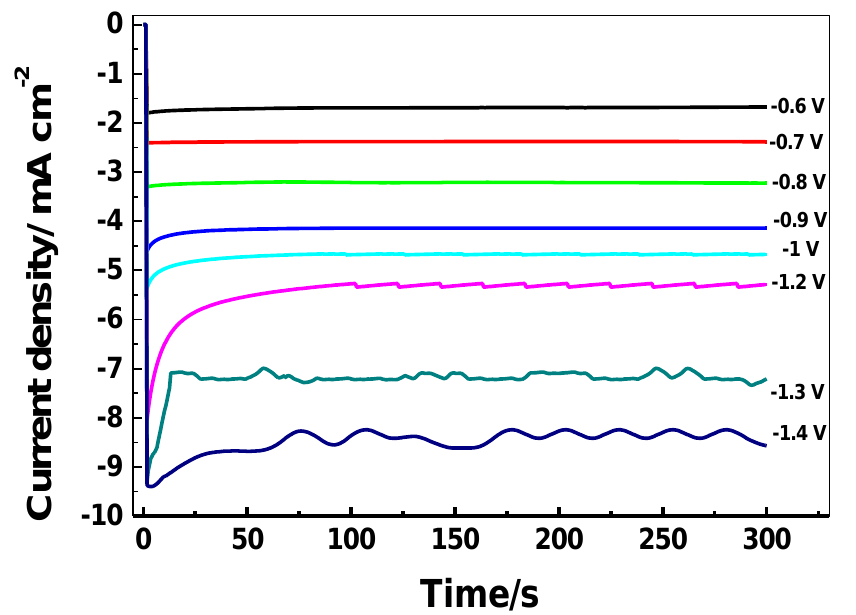
Figure 11. Current – time curves recorded with the Al-Ni-Gr-10% SiC cathode at a constant potential. Figure 11. Current–time curves recorded with the Al-Ni-Gr-10% SiC cathode at a constant